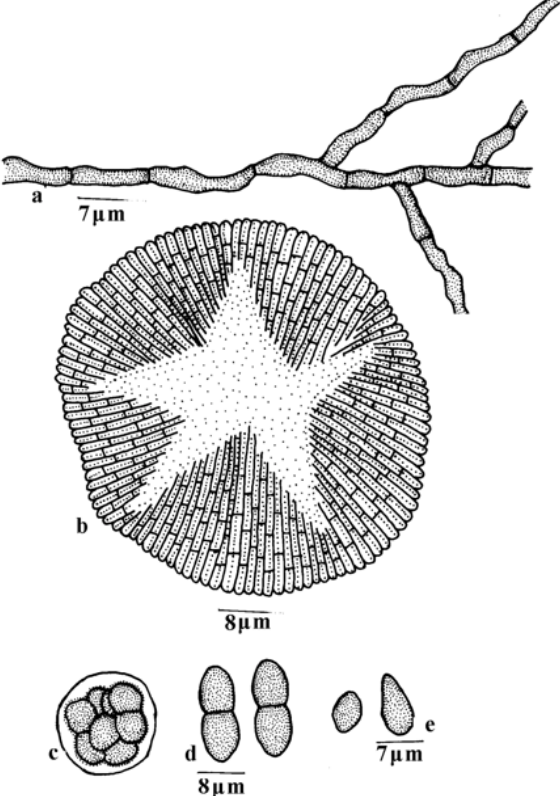
Figure 176. Prillieuxina ixorigena a - Mycelium; b - Thyriothecium; c - Ascus; d -